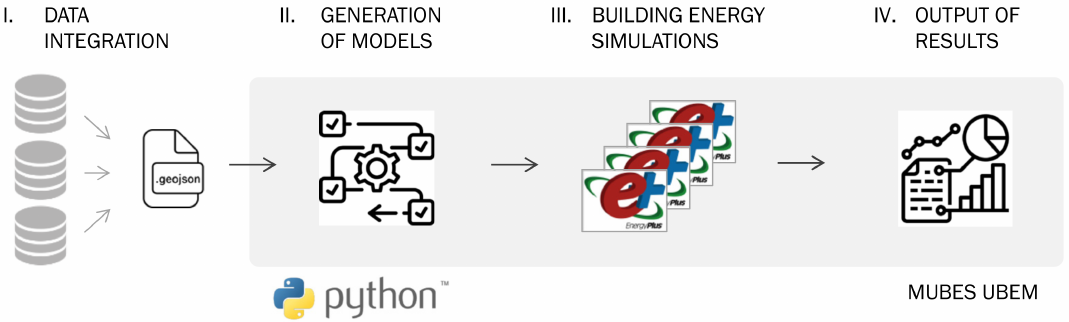
Figure 1. MUBES UBEM